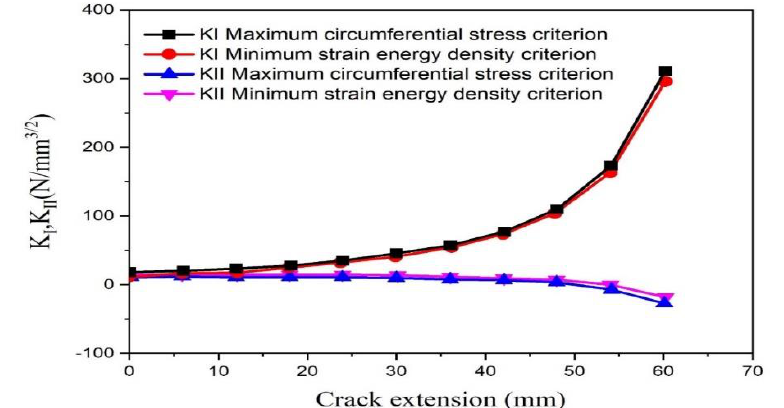
Figure 9. Comparisons of SIFs for the single-edge angled crack.